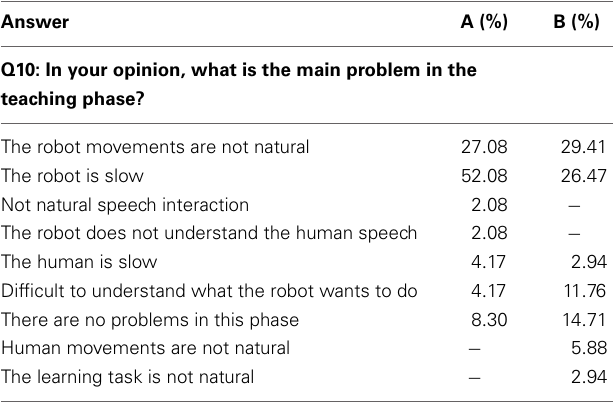
Table 6 | Post-experiment questionnaire for external